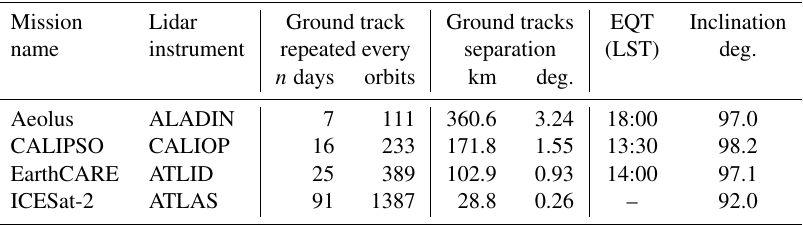
Table 1. Ground track layout parameters for the sun-synchronous lidar missions investigated in our study. EQT refers to the equatorial crossing time for the ascending node, and is given in mean local solar time (LST). The full names of the lidar instruments are: the Advanced Topographic Laser Altimeter System (ATLAS), the Cloud-aerosol Lidar with Orthogonal Polarization (CALIOP), the Atmospheric Lidar (ATLID), the Atmospheric Laser Doppler Instrument (ALADIN). Mission Lidar Ground track Ground tracks EQT Inclination name instrument repeated every separation (LST) deg. n days orbits km deg.